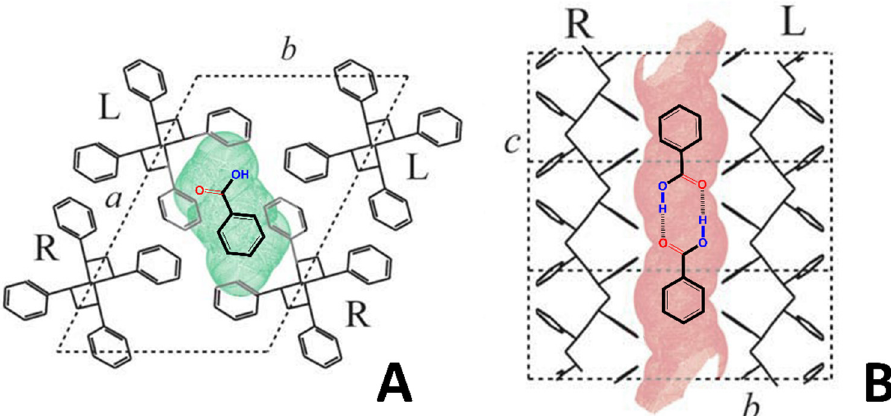
Figure 4. Schematic views of the preferential aggregation and orientation of BA guest molecules in the CC phases of sPS: ( A ) ab is the projection of the CC δ form with isolated BA molecules and guest molecular plane preferentially perpendicular to the helical chain axes; ( B ) bc is the projection of the CC ε phase with dimeric BA molecules and guest molecular planes preferentially parallel to the helical chain axes.